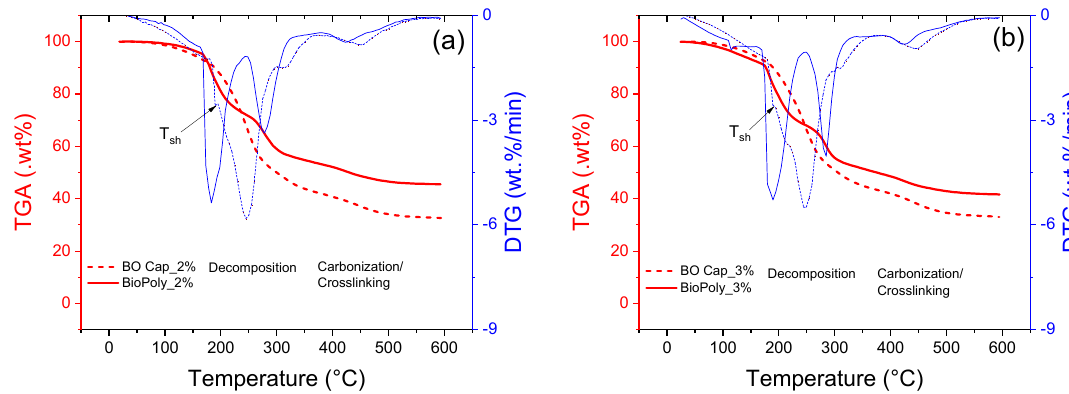
Figure 10. TGA and DTG results of the biopolymer matrix (BioPoly) and BO capsules (BO Cap) for concentrations of ( a ) 2% of alginate; and ( b ) 3% of alginate. T sh is the DTG shoulder temperature.